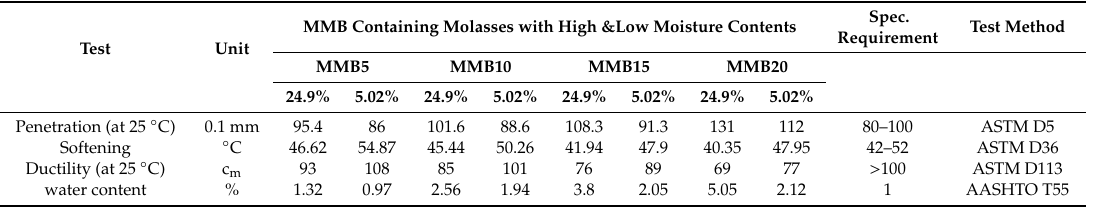
Table 3. Properties of molasses modified binders (MMBs) containing molasses with 24.9% and 5.02% water contents.